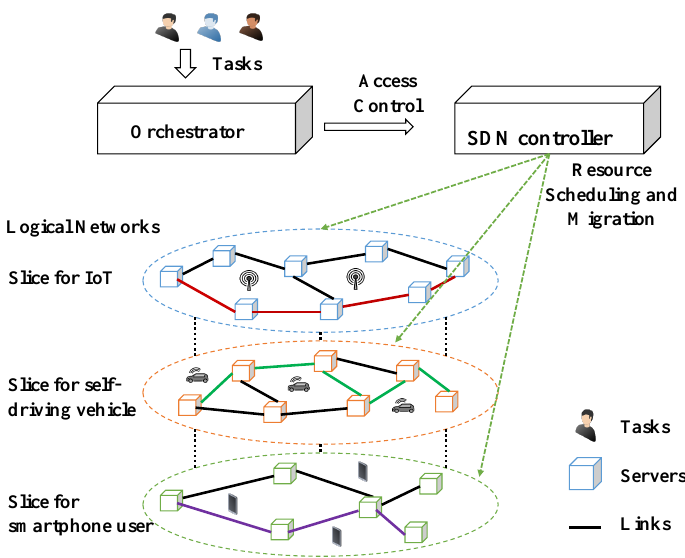
Figure 1. System architecture for orchestrator in a sliced